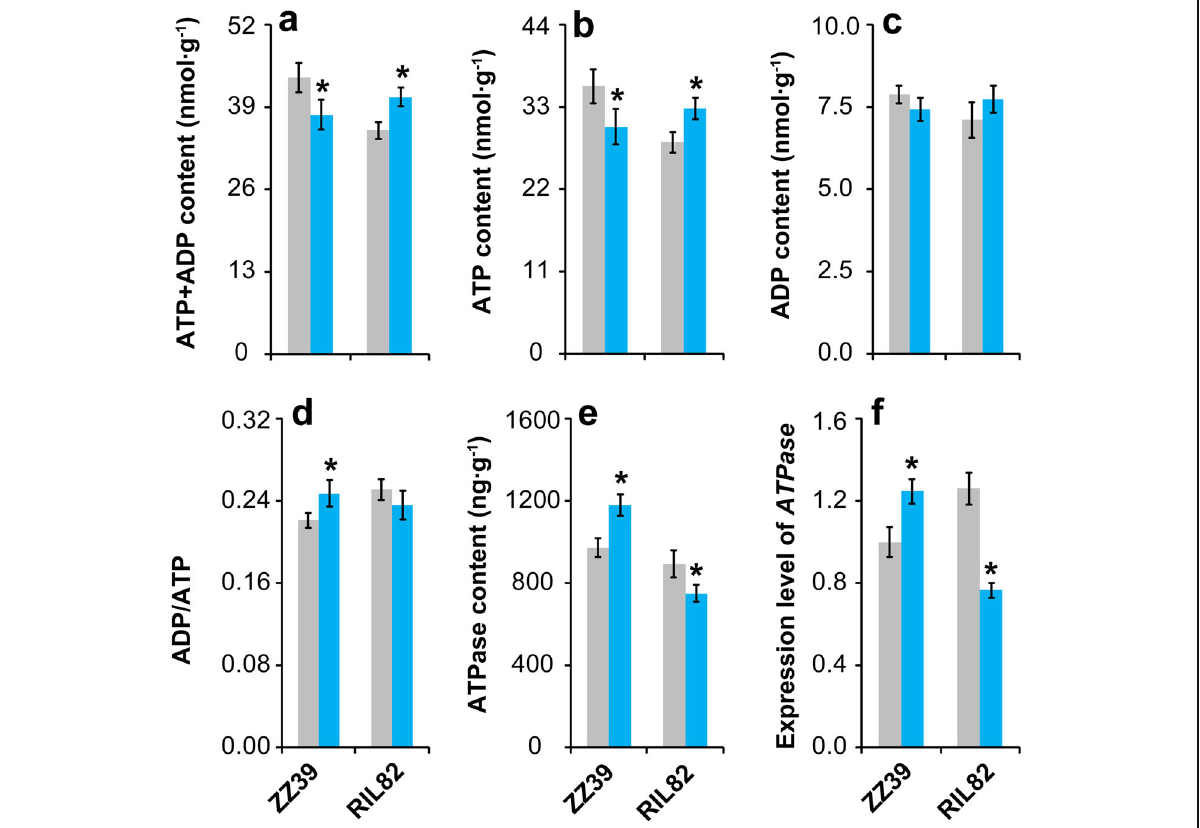
Fig. 5 Effect of cold stress on the ATP metabolism in rice leaves. a , ATP + ADP; b , ATP; c , ADP; d , ADP/ATP; e , ATPase; f , expression level of ATPase . Vertical bars denote standard deviations ( n = 3). A t -test was conducted to compare the difference between control and cold stress within a cultivar. * denotes P <